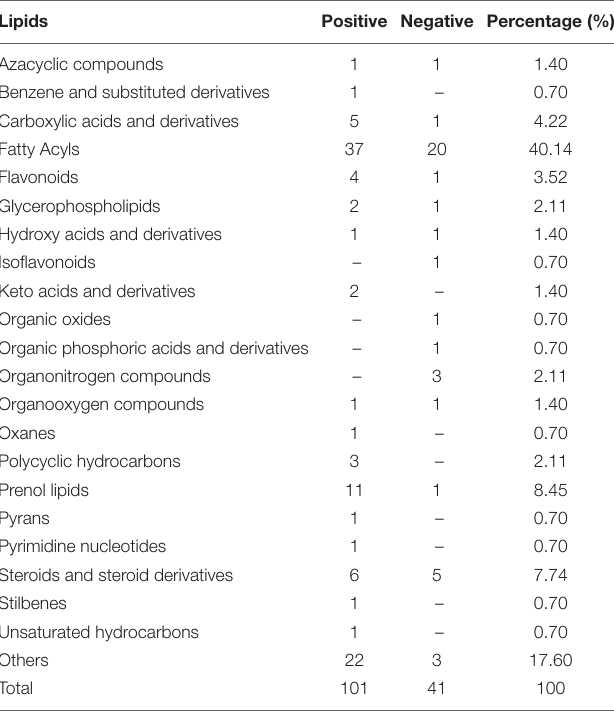
TABLE 2 | Identified metabolites using HPLC-MS profiling in Rhodotorula glutinis X-20. Metabolites